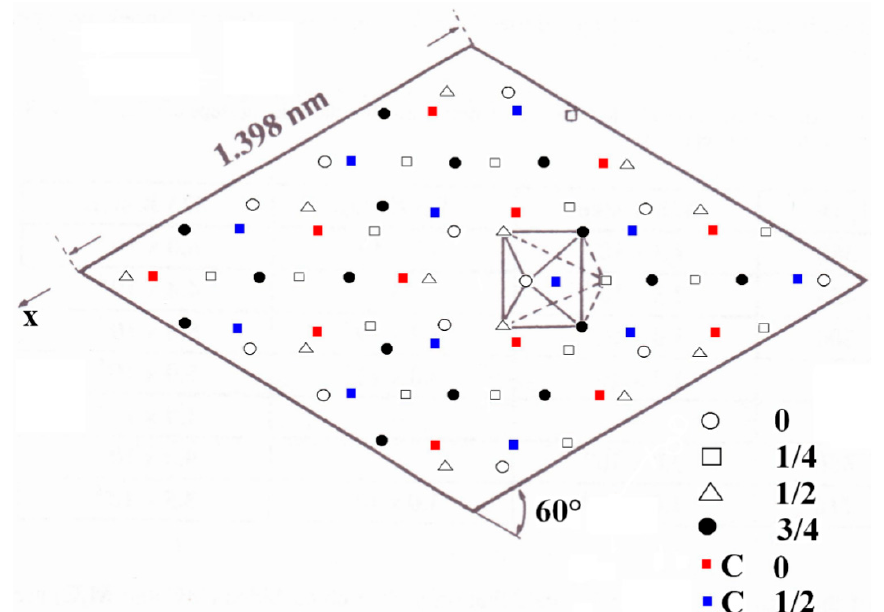
Figure 11. Cr 7 C 3 carbide cell according to Dyson and Andrews [40].